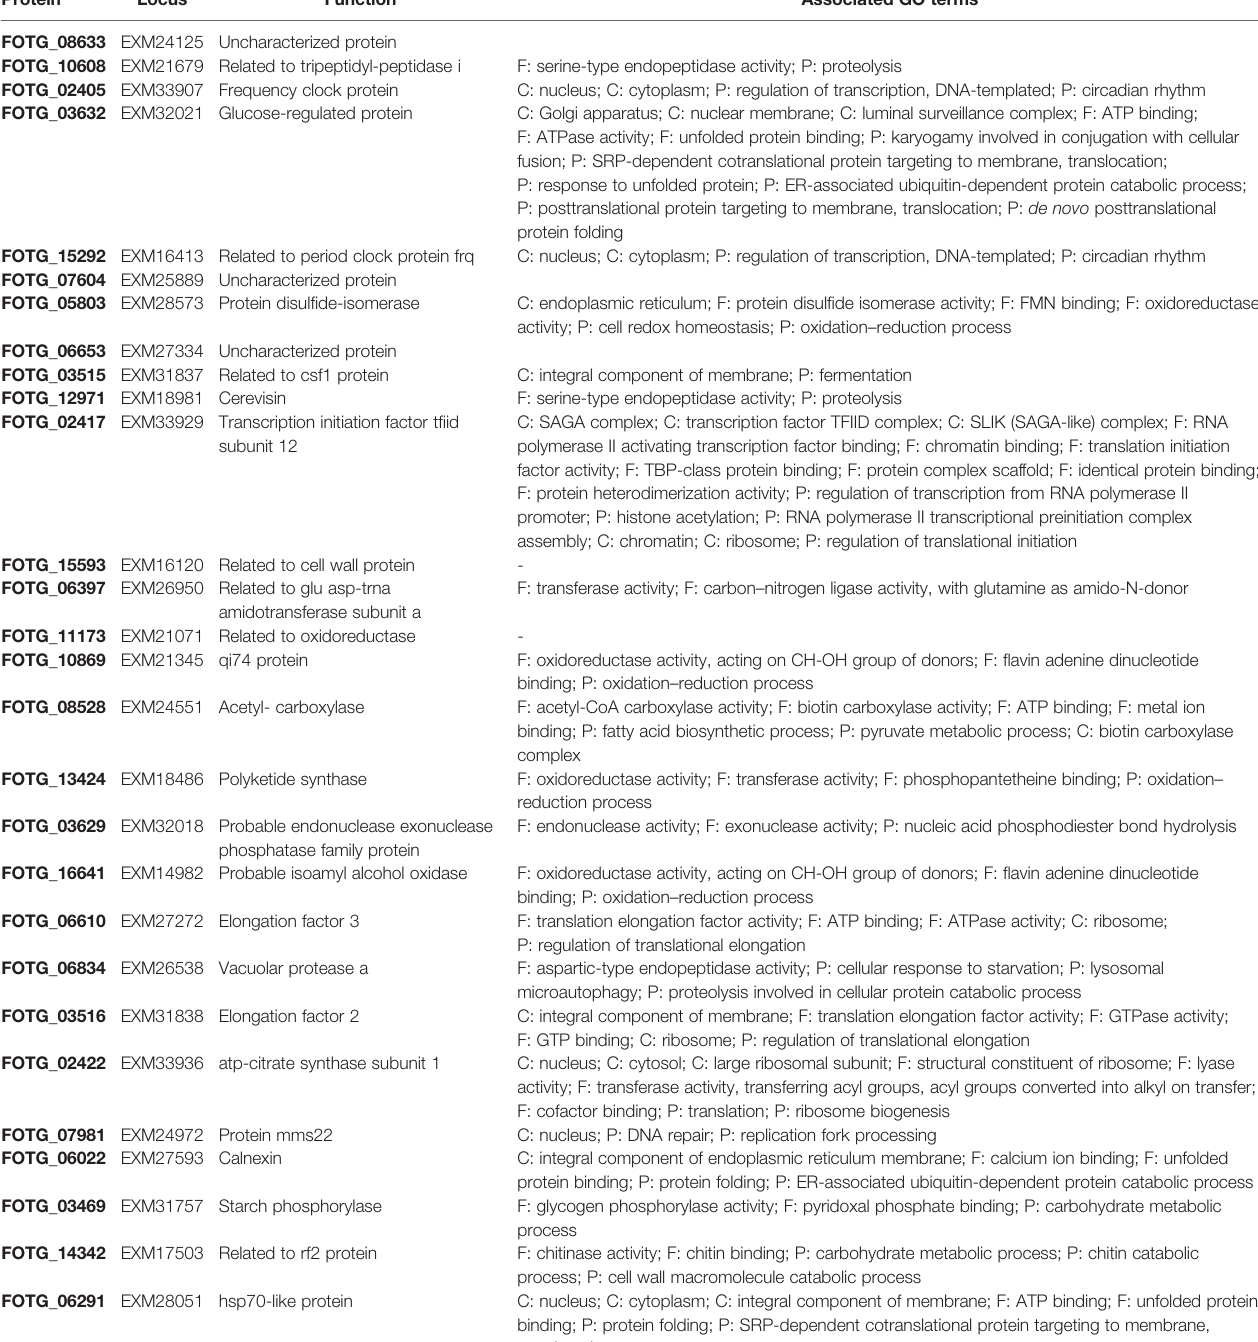
TABLE 1 | The 30 most abundant proteins identi fi ed in F. oxysporum f. sp. vasinfectum EVs. Protein Locus Function Associated GO terms FOTG_08633 EXM24125 Uncharacterized protein FOTG_10608 EXM21679 Related to tripeptidyl-peptidase